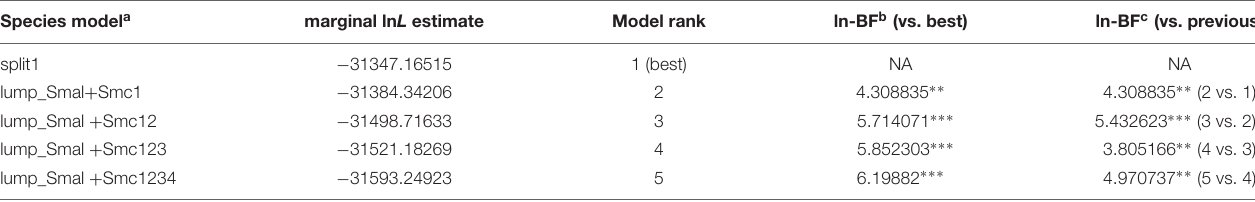
TABLE 2 | Bayes factor (BF) analysis for five species delimitation hypotheses within the S. maltophilia complex, plus genogroups #8 and #10, based on marginal likelihoods computed for each hypothesis by path sampling (see Materials and Methods). Species model